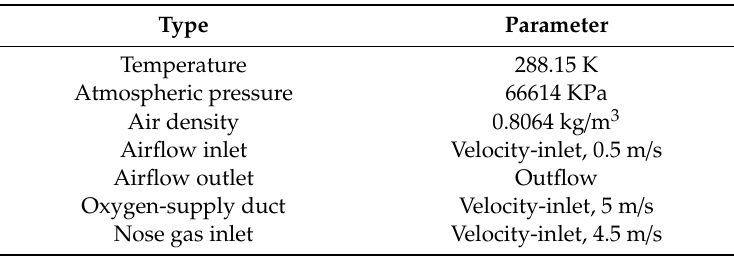
Table 1. Boundary